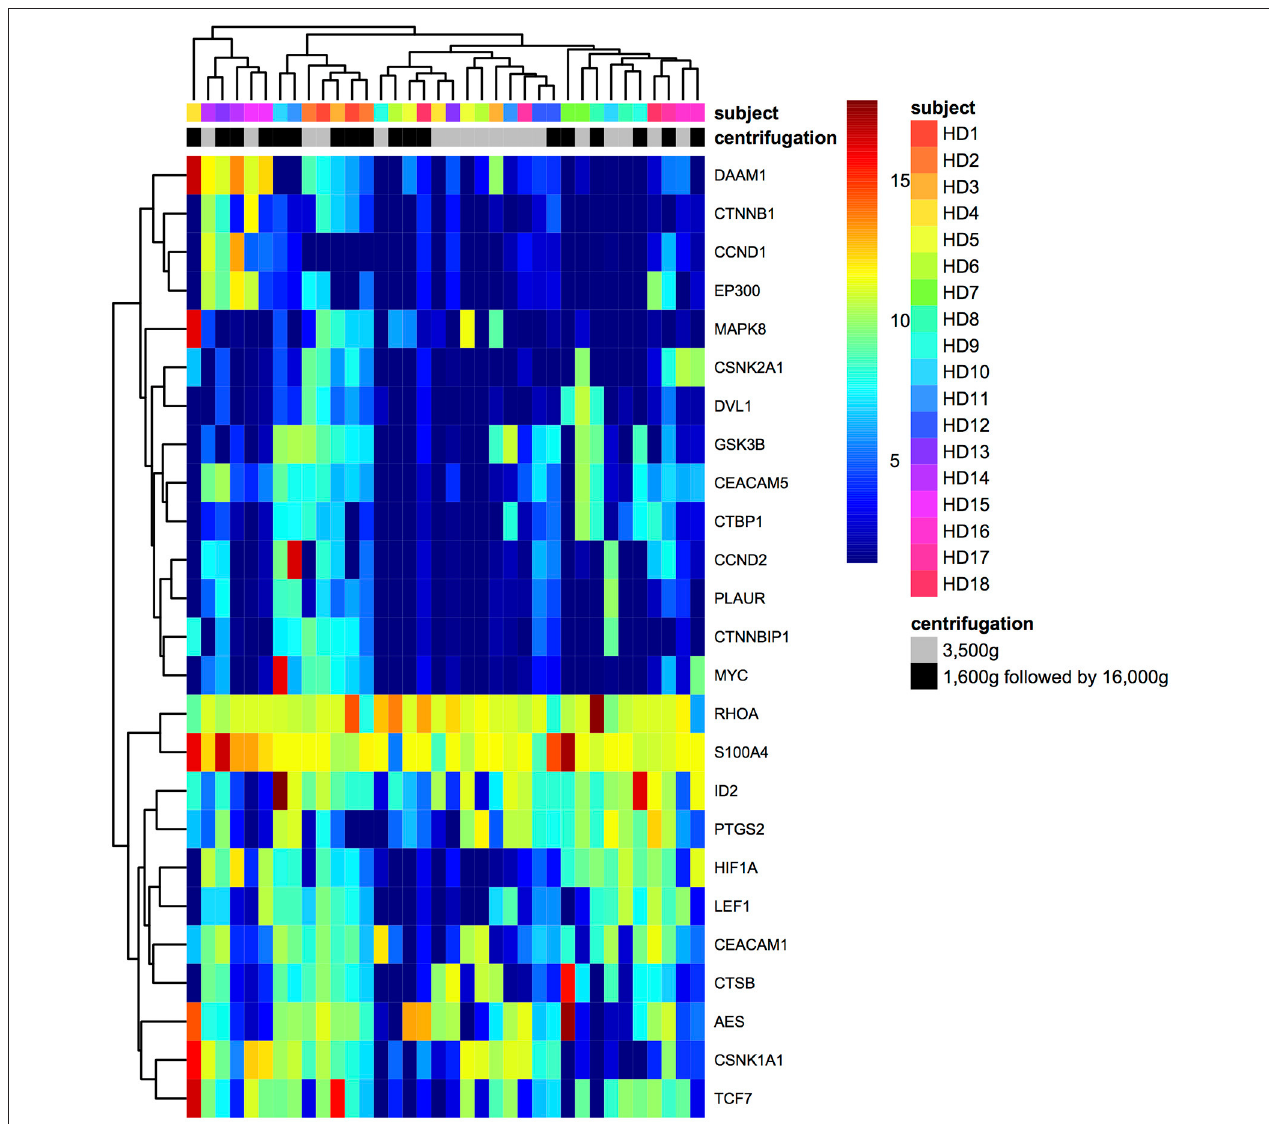
FIGURE 4 | The hierarchical clustering for samples and gene